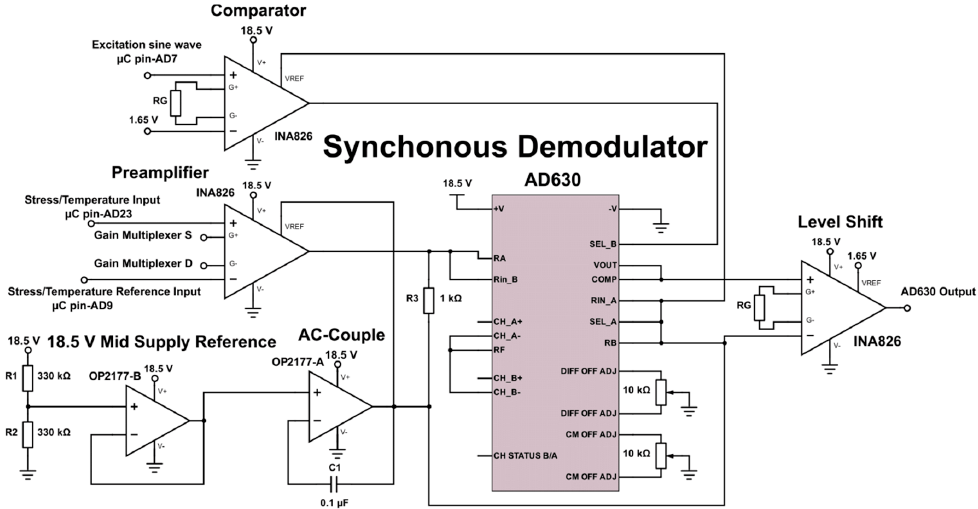
Figure 12. Circuit schematic of the AC coupled AD630 synchronous demodulator in a lock-in amplifier configuration.